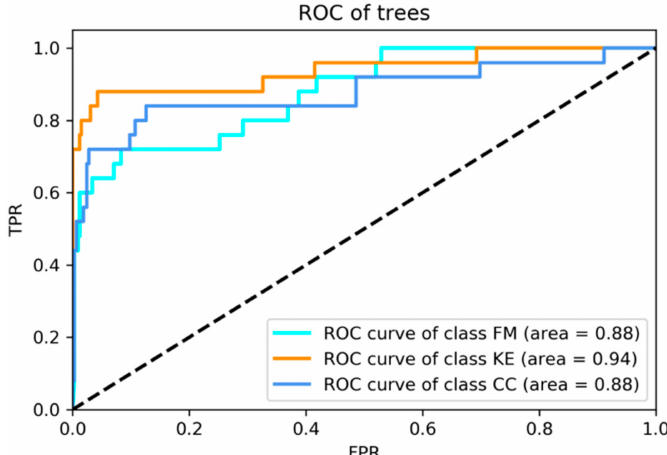
Figure 6. Receiver operating characteristic (ROC) curves of the top three major classes, Ficus micro- carpa (FM), Koelreuteria henryi (KE), and Cinnamomum camphora (CC). TPR: true positive rate; FPR: false positive